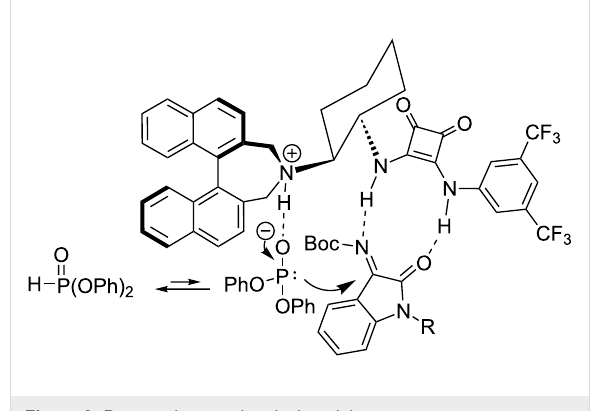
Figure 2: Proposed stereochemical